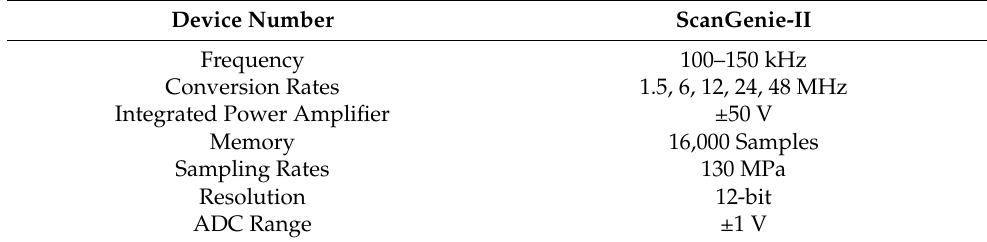
Figure 3. The experiment setup. Table 2. Piezoelectric monitoring equipment technical